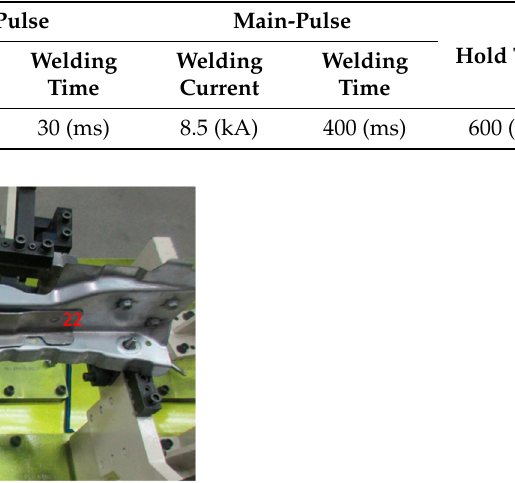
Figure 12. Welded vehicle parts. The red numbers indicate welding orders. Table 2. Welding conditions.